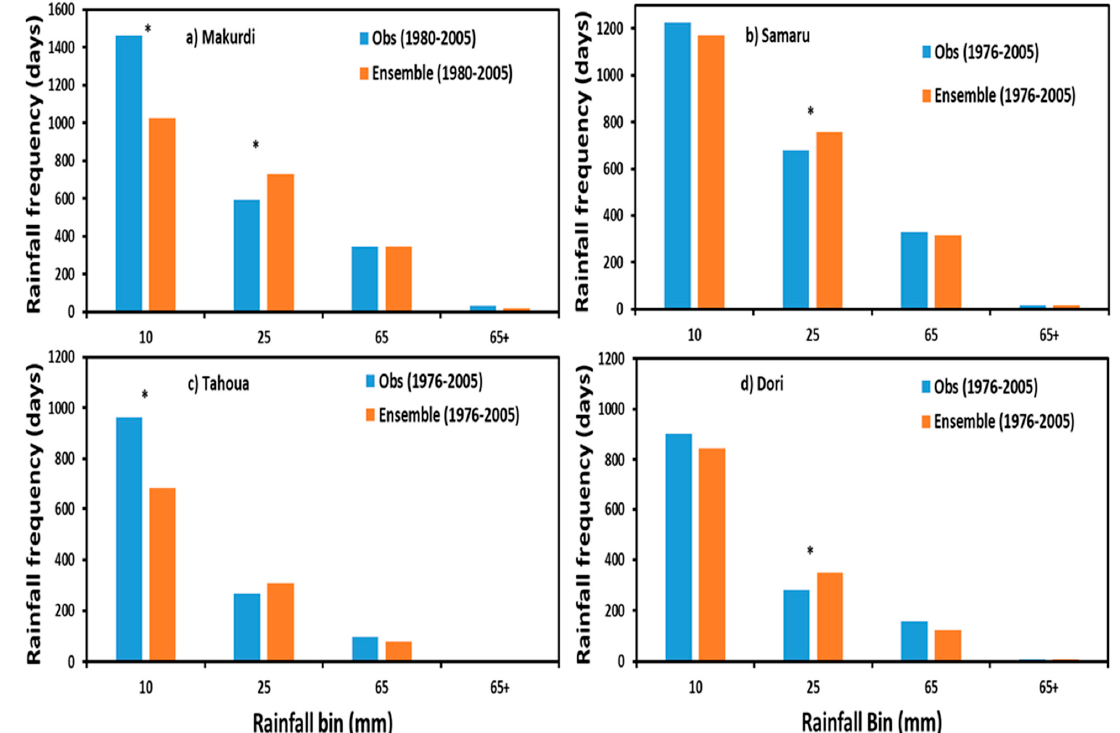
Figure 2. A comparison of the Coordinated Regional Climate Downscaling Experiments (CORDEX) multi-models ensemble and observed frequency of rainfall at different intensities (low, moderate, heavy and extreme) over the ( a ) Southern (Makurdi) and ( b ) Northern (Samaru) Guinea agro-ecological zones and ( c , d ) the Sahelian (Tahoua and Dori) agro-ecological zones for the historical period, 1976/1980–2005. Note, * indicate where the events are significantly different at 0.05 using t-test for mean.